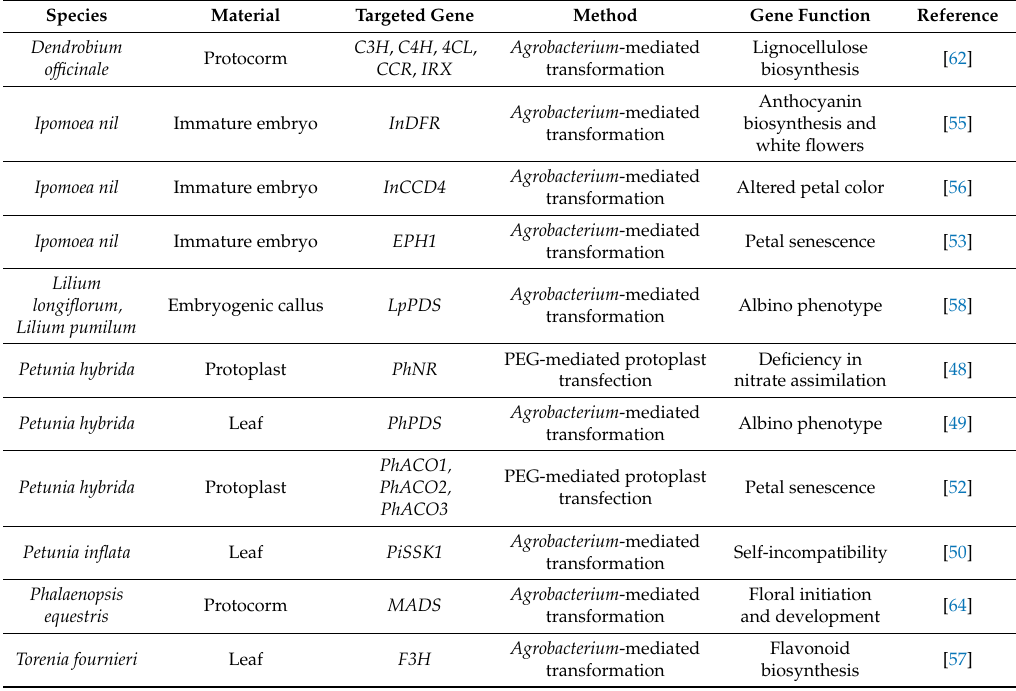
List of recent successes in clustered regularly interspaced short palindromic repeats–CRISPR-associated (CRISPR-Cas) systems of ornamental